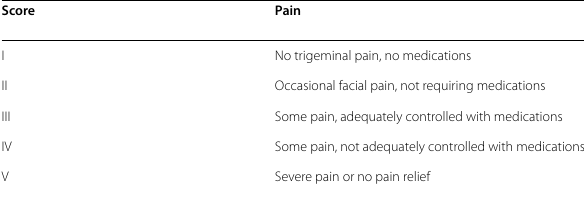
Table 1 Barrow neurological institute pain scale